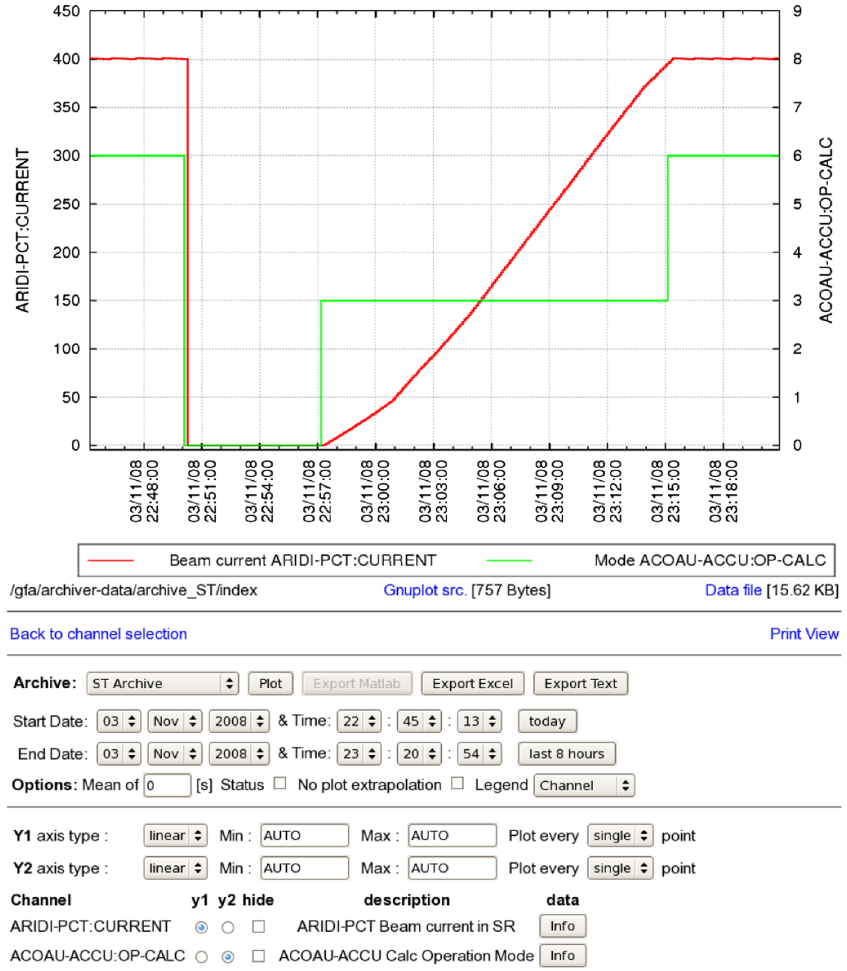
FIG. 5. (Color) A sample screen shot of the channel archiver Web